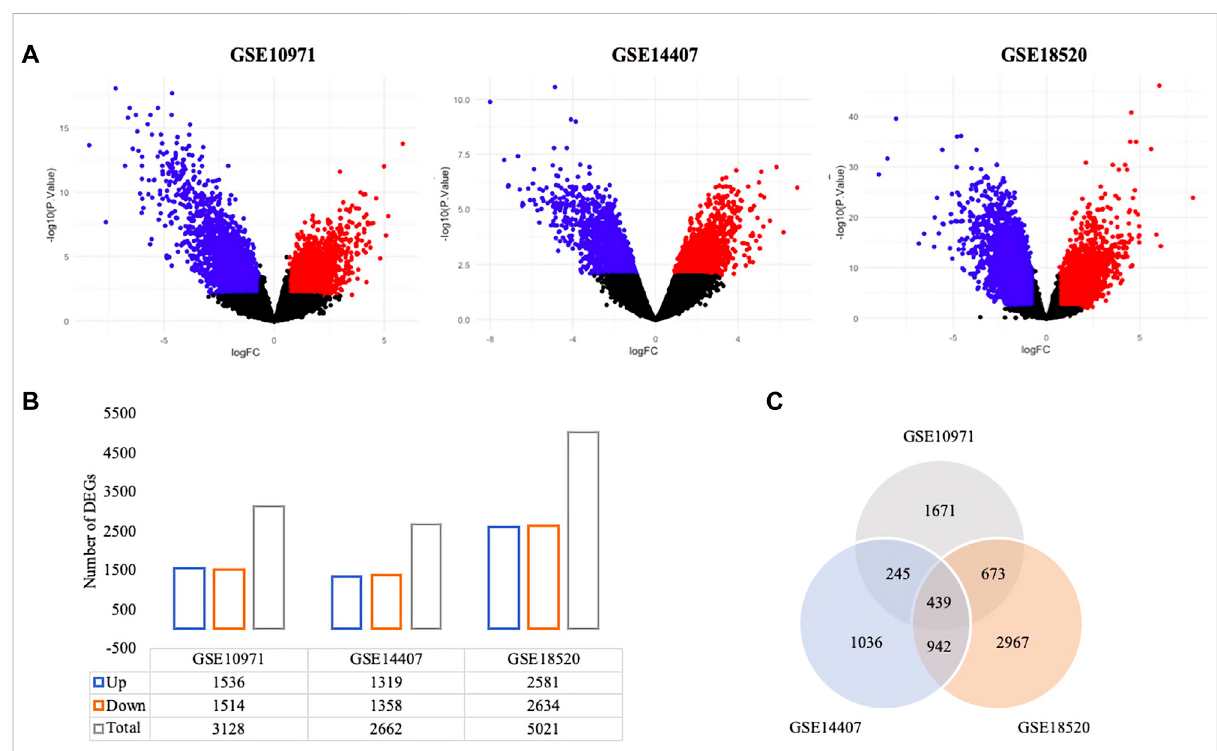
FIGURE 1 Differentially expressed genes (DEGs) in ovarian cancer. (A) The volcano plots of gene expression datasets; red and blue dots represent the up- and down-regulated DEGs at an adjusted p -value threshold of 0.01, respectively. (B) The distribution of up- and down-regulated DEGs (adjusted p -value < 0.01). (C) Venn diagram representation of DEGs across gene expression